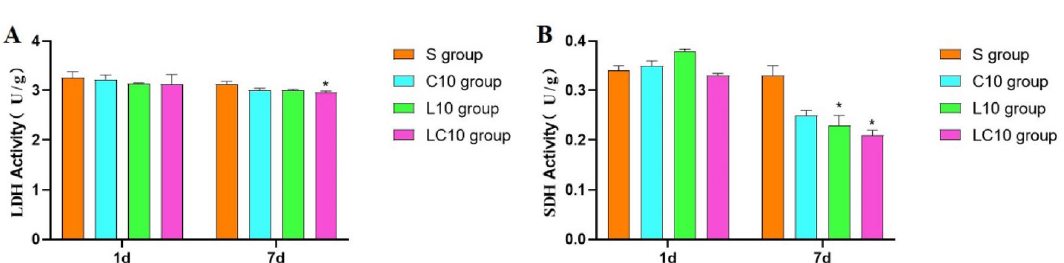
Figure 5. The contents of Nissl substances at 7 days after 1.5-GHz and 4.3-GHz microwave irradiation (scale bar = 20 μm, A – D ), ( A ) S group, the Nissl substance contents were normal. ( B – D) C10 group, ( C ) L10 group and D: LC10 group, the Nissl substance contents decreased to varying degrees. Quantitative analysis of Nissl body content in the hippocampal tissue of each group at various time points after irradiation ( E ). Quantized data are shown as the mean ± SE. *P < 0.05, **P < 0.01 vs. control; ✩ P < 0.05 LC10 vs. C10. The relative content of Nissl body is measured by Image-Pro Plus 6.0. Figure E was drawn by Graph Pad Prism 6 and the data were analyzed by SPSS 22.0.